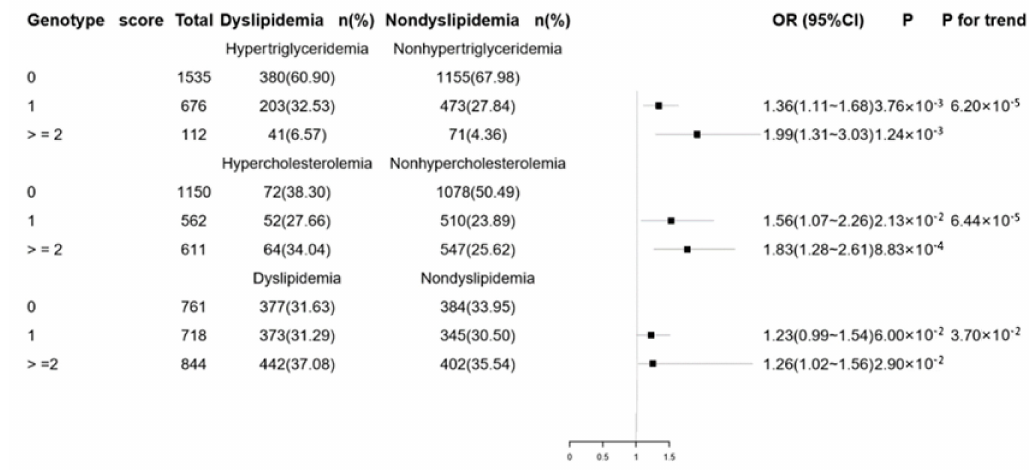
Figure 1. Cumulative e ff ects of the risk alleles on dyslipidemia. Number of risk alleles for hypertriglyceridemia including two single-nucleotide polymorphisms (SNPs): Rs662145 and rs11643718. Number of risk alleles for hypercholesterolemia including 2 SNPs: Rs1003723 and rs6413504. Number of risk alleles at the for dyslipidemia including 4 SNPs: Rs662145, rs11643718, rs1003723, and rs6413504. Adjusted for sex, age, BMI, waist circumference, smoking, drinking, and exercise. The above results are still statistically significant after a Bonferroni